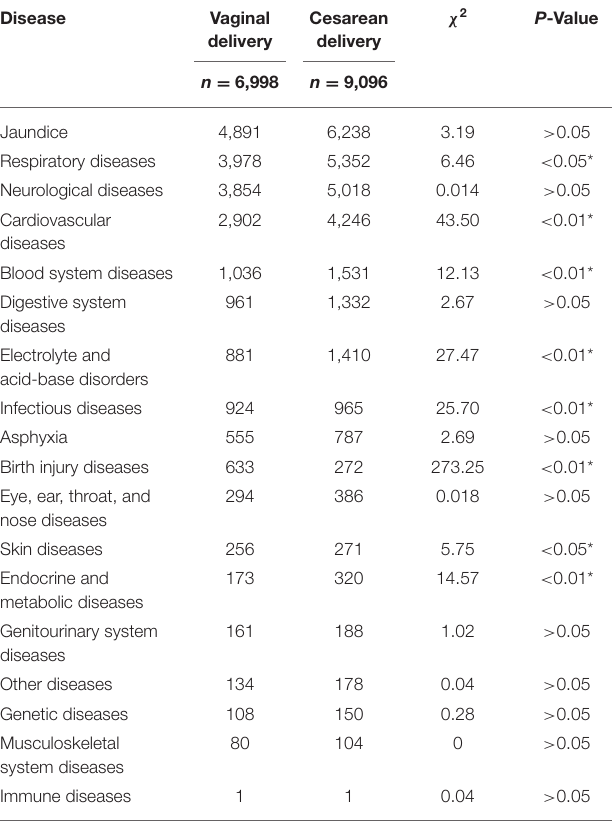
TABLE 7 | Prevalence of neonatal diseases in relation to delivery method.